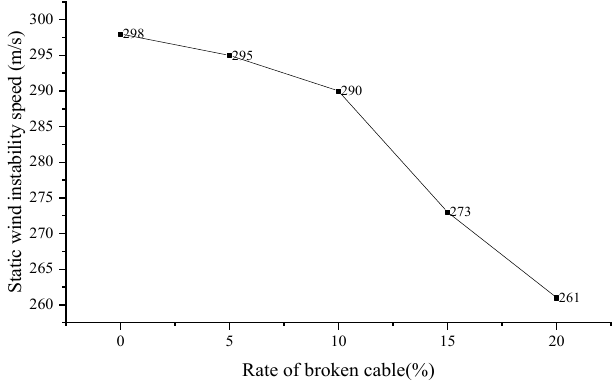
Figure 13. Critical aerostatic instability wind speed with the steel wire breakage rate.